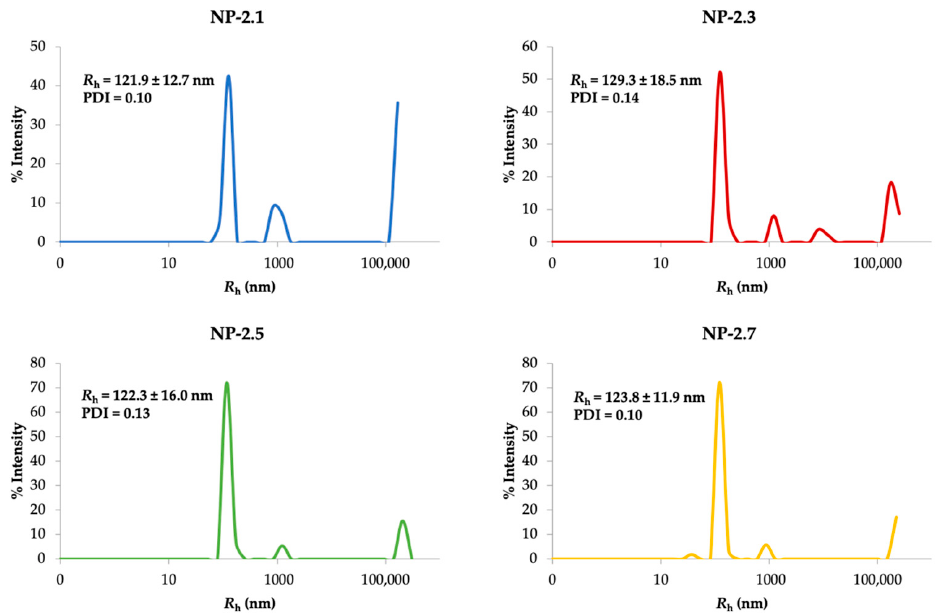
Figure 6. Representative particle size distribution of S14-loaded PLGA-NPs. Results are shown as the mean of 40 measures ± standard deviation (SD). PDI refers to polydispersity of NPs.